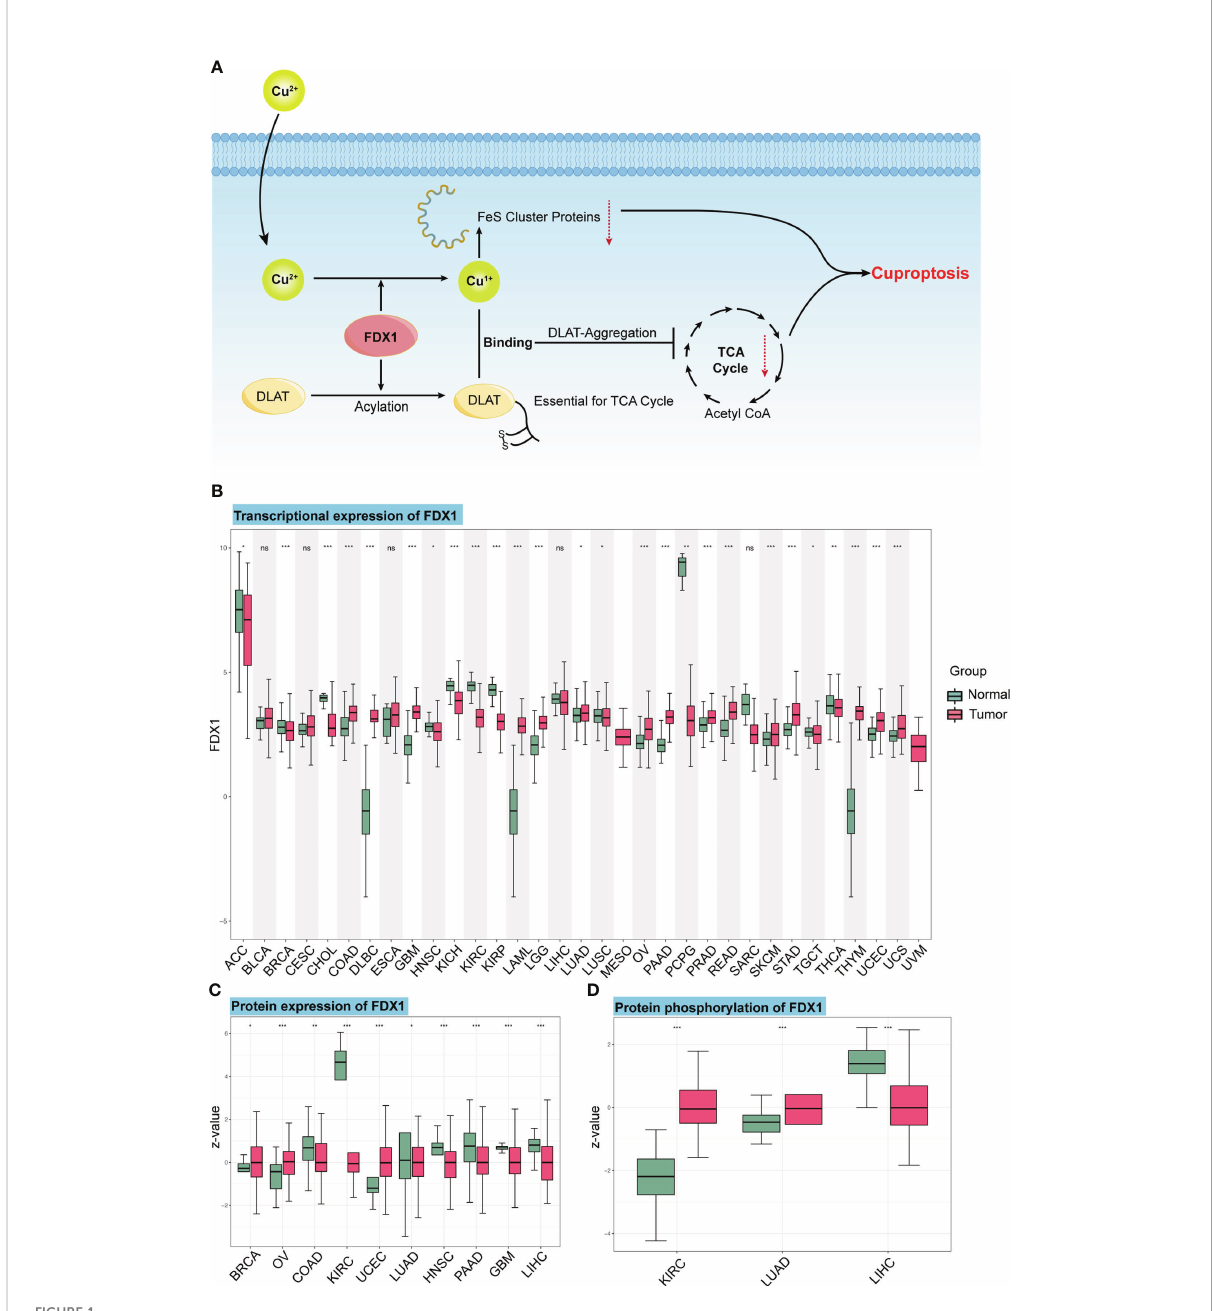
FIGURE 1 The mechanism of cuproptosis and expression of FDX1 at different levels. (A) FDX1 works as the core regulatory gene in the process of copper- induced death. (B) FDX1 is differently expressed in the 33 tumors at the transcriptional level. (C, D) Protein level and phosphorylation of FDX1 in different tumors and normal tissues based on data from CTPAC. ns, not signi fi cant, p ≥ 0.05; *p < 0.05; **p < 0.01; ***p < 0.001. (Cu, copper; FDX1 , ferredoxin 1; TCA, tricarboxylic acid; DLAT, dihydrolipoamide